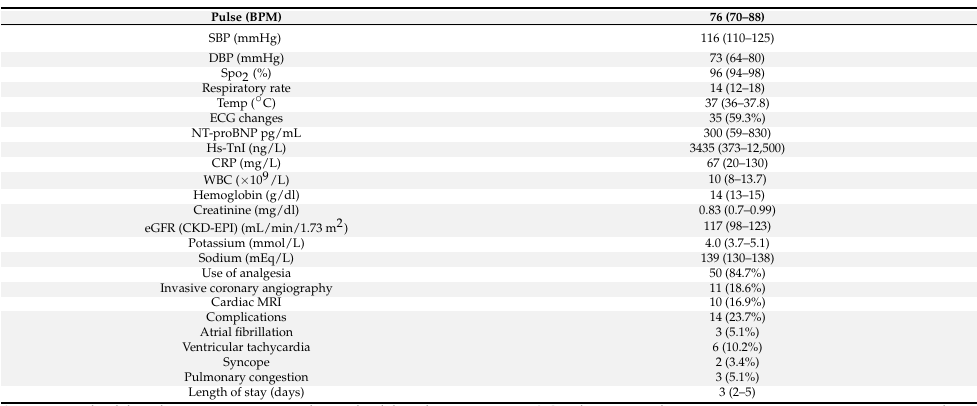
Table 3. Basic hemodynamic, laboratory and